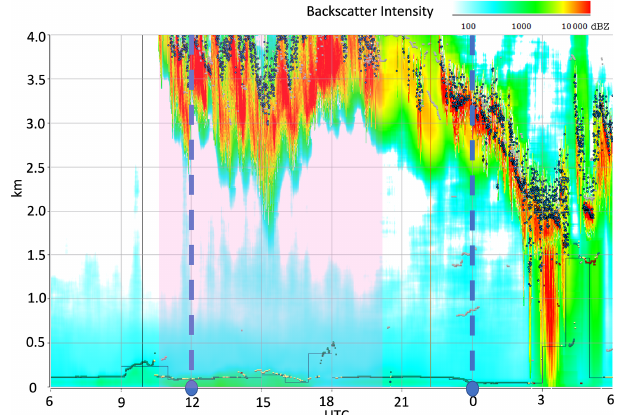
Figure 7. Virga event from 10–11 March 2019 (shaded region), starting from 10:30–20:00UTC. Light precipitation can also be ob- served between 03:00 and